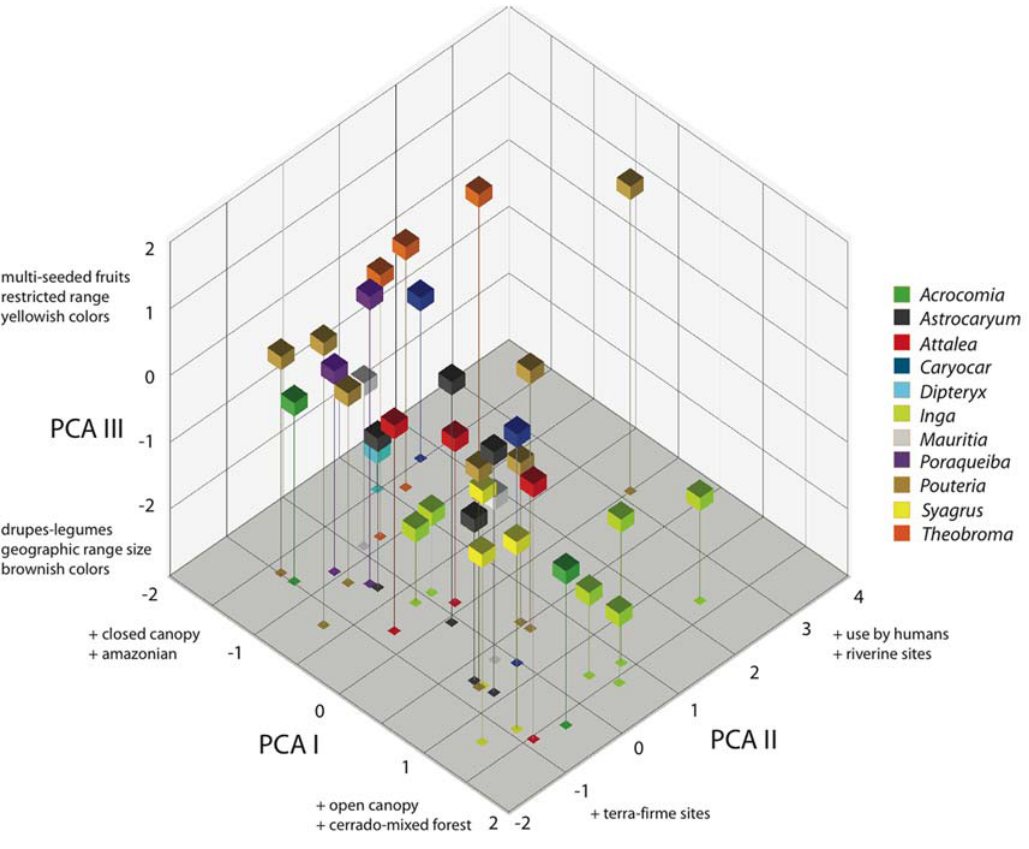
Figure 5. Principal components analysis of ecological and life-history variables of megafauna fruit species. Only genera ( N =11) with several species available for the analyses have been included. Cubes indicate the relative positions of individual species on the space defined by the three first principal components. Axes are labeled with short descriptions of the variables having larger loads ( . 0.40) on them.